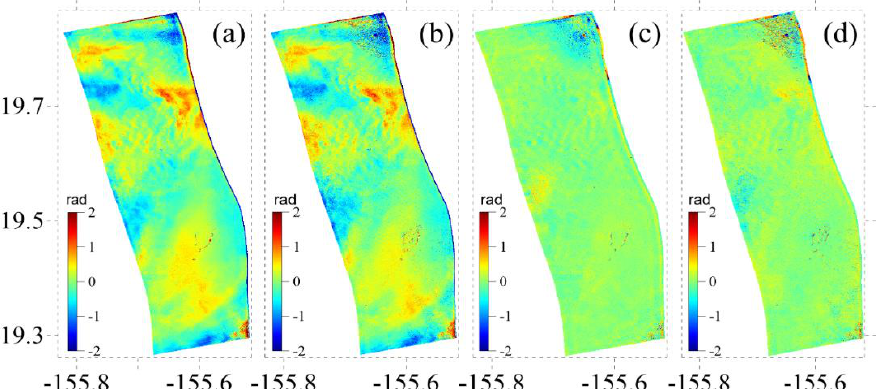
Figure 5. The unwrapped D-Infs of the HH and HV polarizations, corrected by the proposed method. ( a ) and ( b ) after the correction of ionospheric and orbit errors; and ( c ) and ( d ) after the atmospheric error correction.